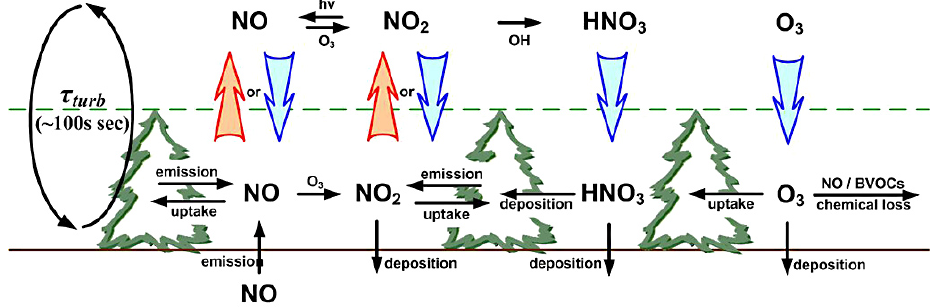
Figure 1. Schematic of the various interactions involved in the exchange of nitrogen oxides between the atmosphere and the forest canopy. Bold arrows in blue (downward) and red (upward) represent the direction of the flux of each species across the canopy